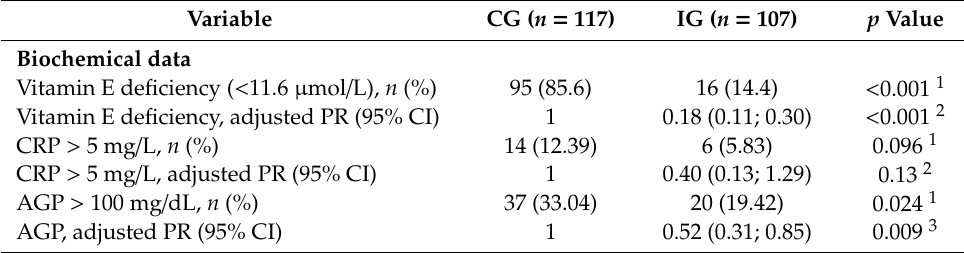
Table 3. Prevalence and prevalence ratio for vitamin E deficiency and inflammatory status between control and intervention groups at the end of the ENFAC study (Goi â nia, 2013; n =